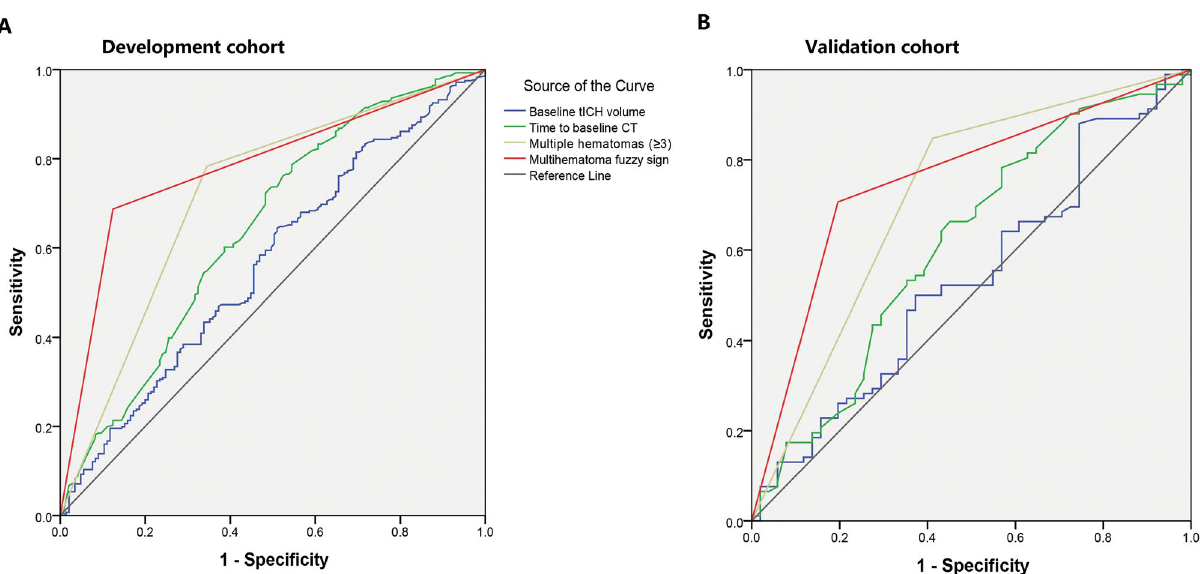
Figure 5. ROC curves for baseline tICH volume, time to baseline CT, the presence of multiple hematomas, and the presence of multihematoma fuzzy sign in predicting acute tICH expansion in the development ( A ) and validation cohorts ( B